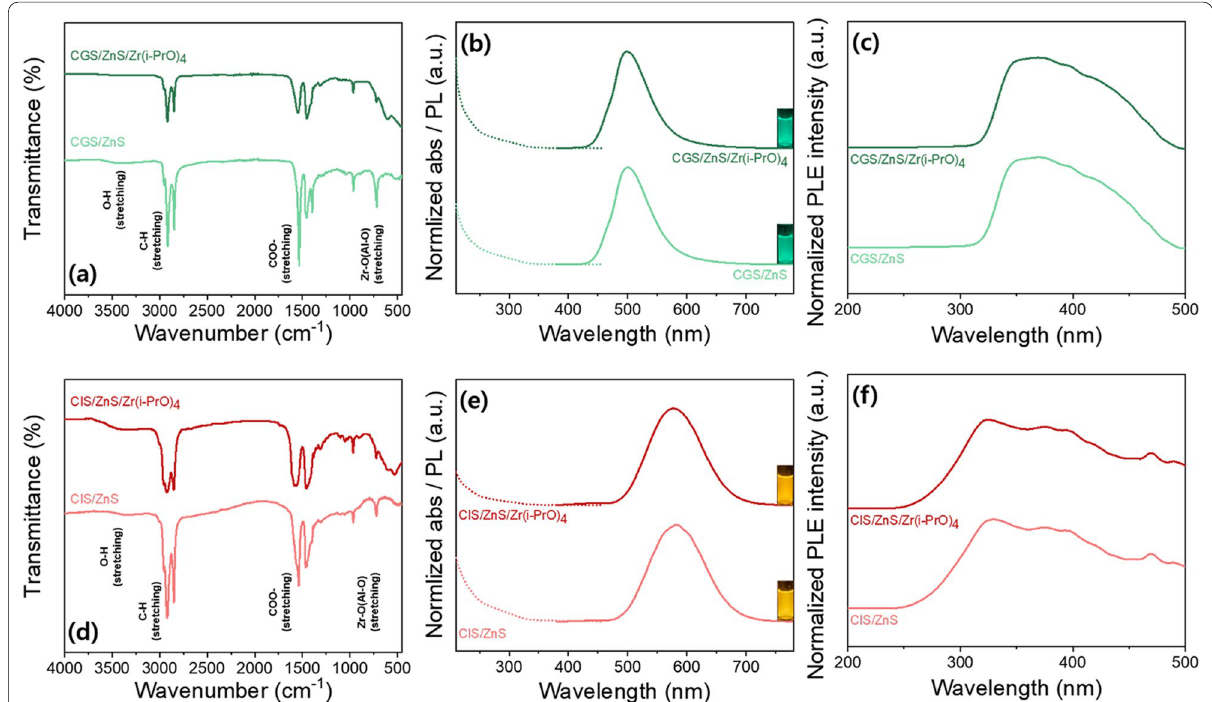
Fig. 4 FT-IR spectra of a green pristine CGS/ZnS and CGS/ZnS/Zr(i-PrO) 4 and d red pristine CIS/ZnS and CIS/ZnS/Zr(i-PrO) 4 QD solutions. PL emission spectra, absorbance, and photographs of emitting solutions (inset) of b green pristine CGS/ZnS, CGS/ZnS/Zr(i-PrO) 4 and e red pristine CIS/ZnS and CIS/ZnS/Zr(i-PrO) 4 QD solutions. c PLE spectra of green pristine CGS/ZnS, CGS/ZnS/Zr(i-PrO) 4 and f red pristine CIS/ZnS and CIS/ZnS/ Zr(i-PrO) 4 QD solutions